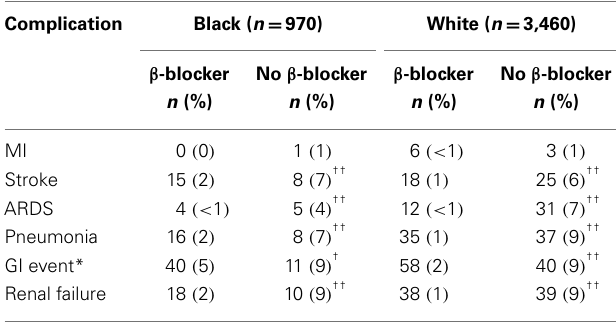
Table 3 | Postoperative complications .